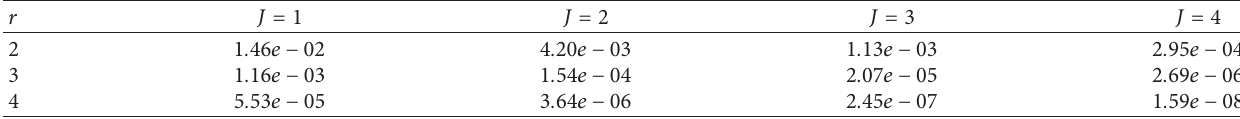
Table 4: Effects of the multiplicity parameter r and refinement level J for Example 2.